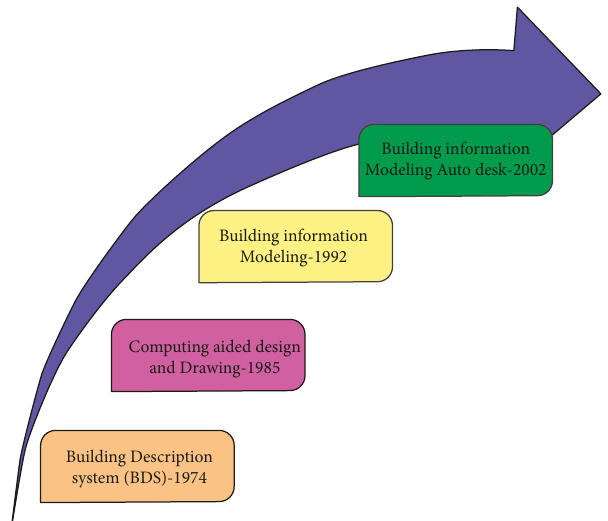
Figure 5: Historical development of BIM.